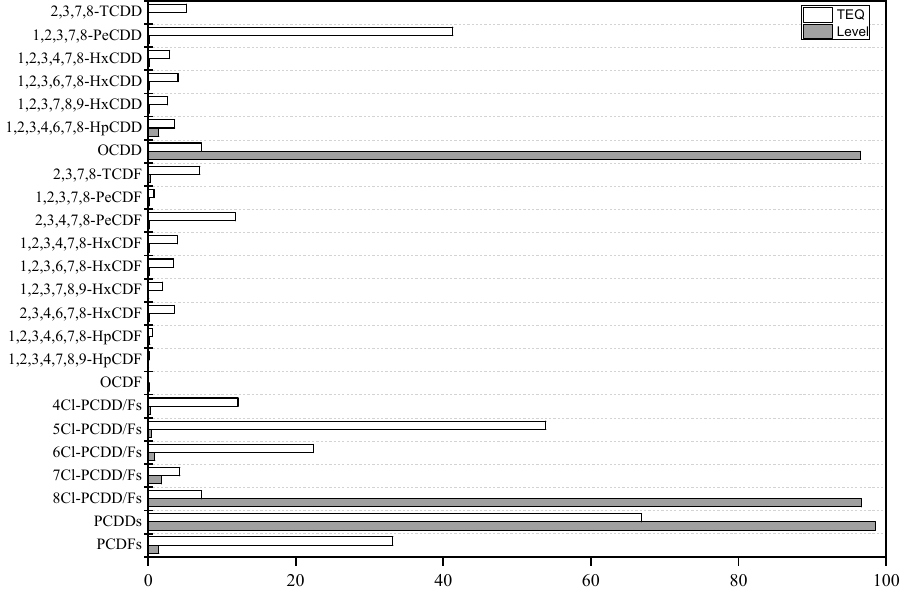
Figure 1. The contributions of congeners to total PCDD/Fs in maternal serum (%).